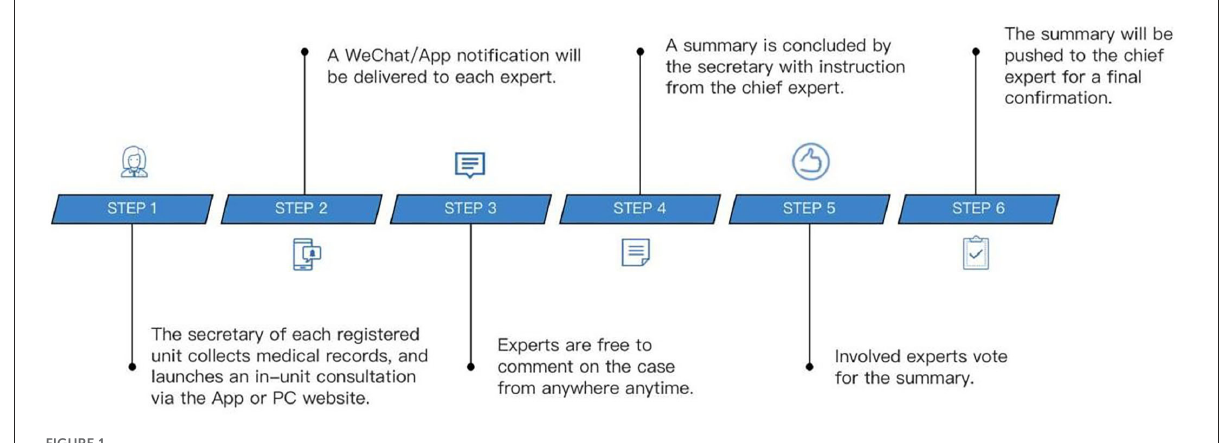
FIGURE1 Work flow of the multidisciplinary team (MDT) system in a single